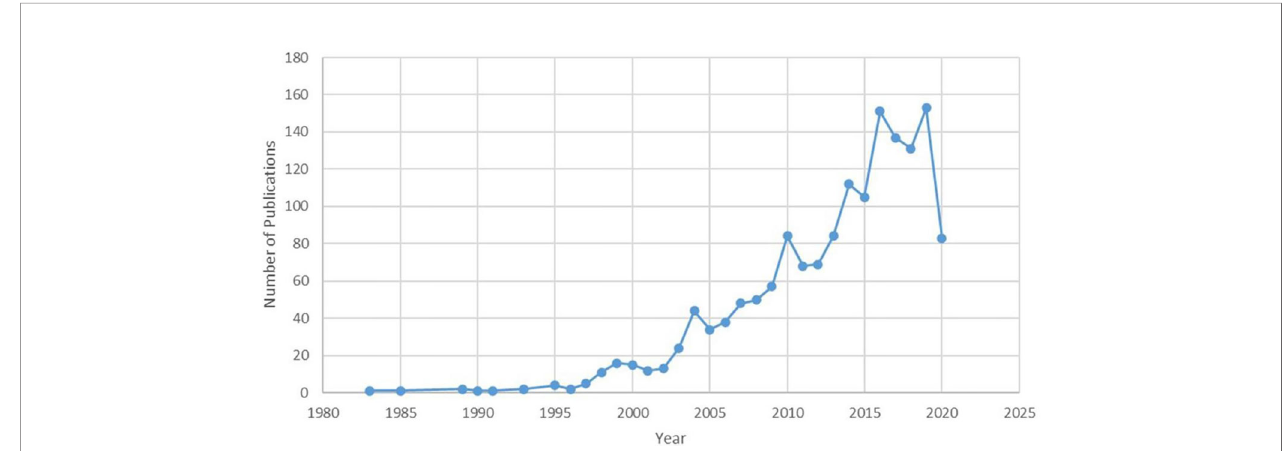
FIGURE 1 | Publication of HIRT related papers (as of the end of August